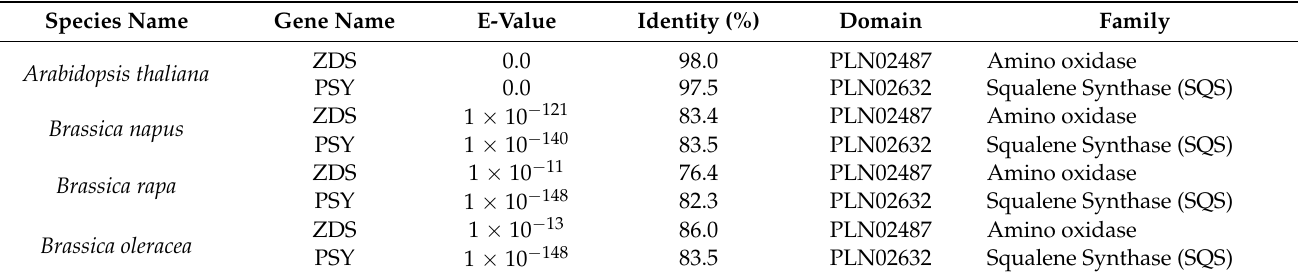
Table 1. E-values, identities and domains found by using BLAST (Basic Local Alignment Search Tool), CDD (Conserved Domains Database) and Pfam (Protein